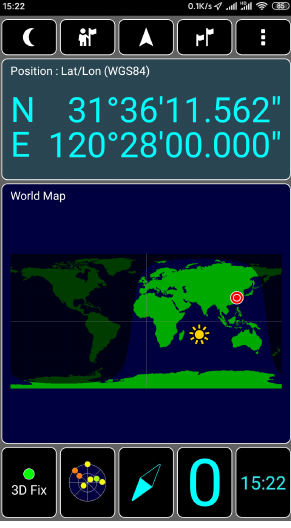
Figure 20. Spoofing position of test mobile